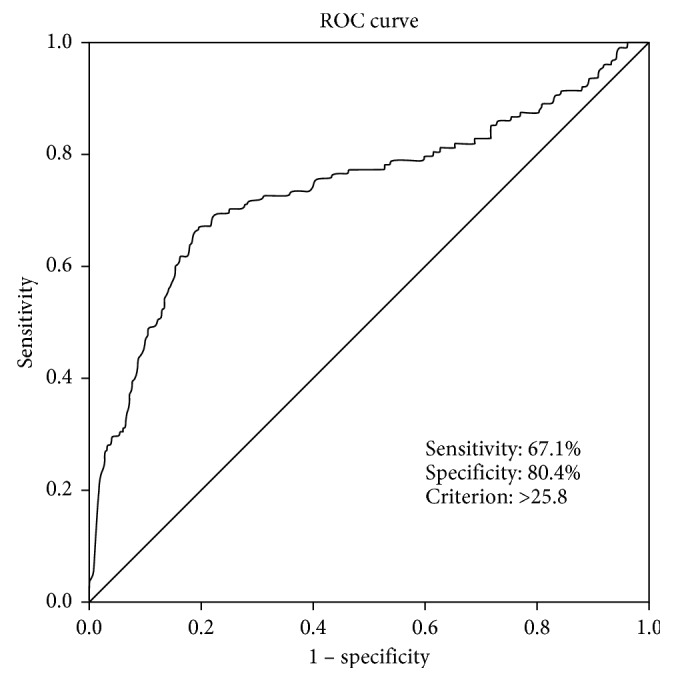
ROC curve analysis plot to determine the cut-off value of TRI in prediction of CIN.